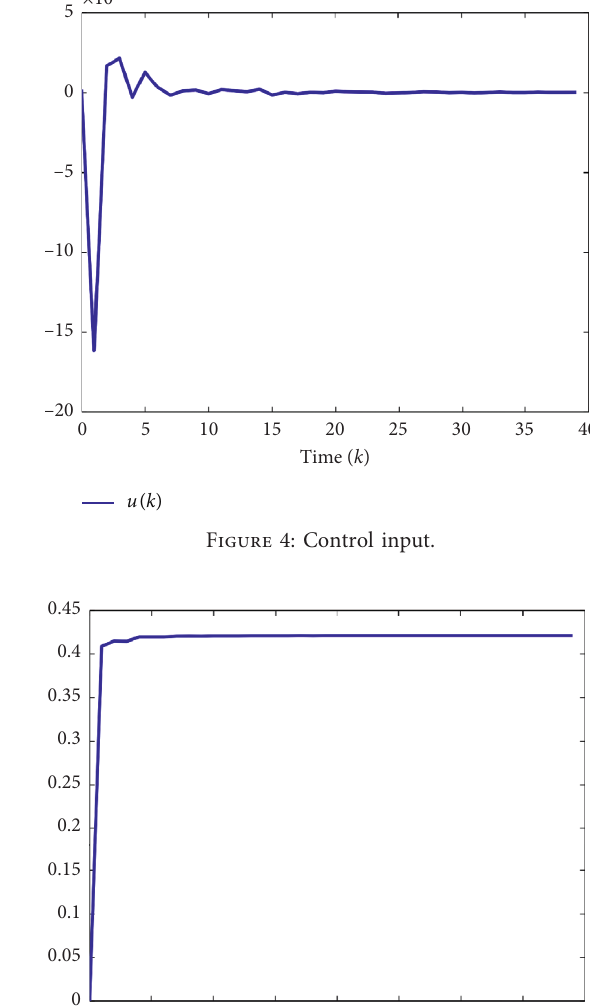
Figure 2: Controller mode.